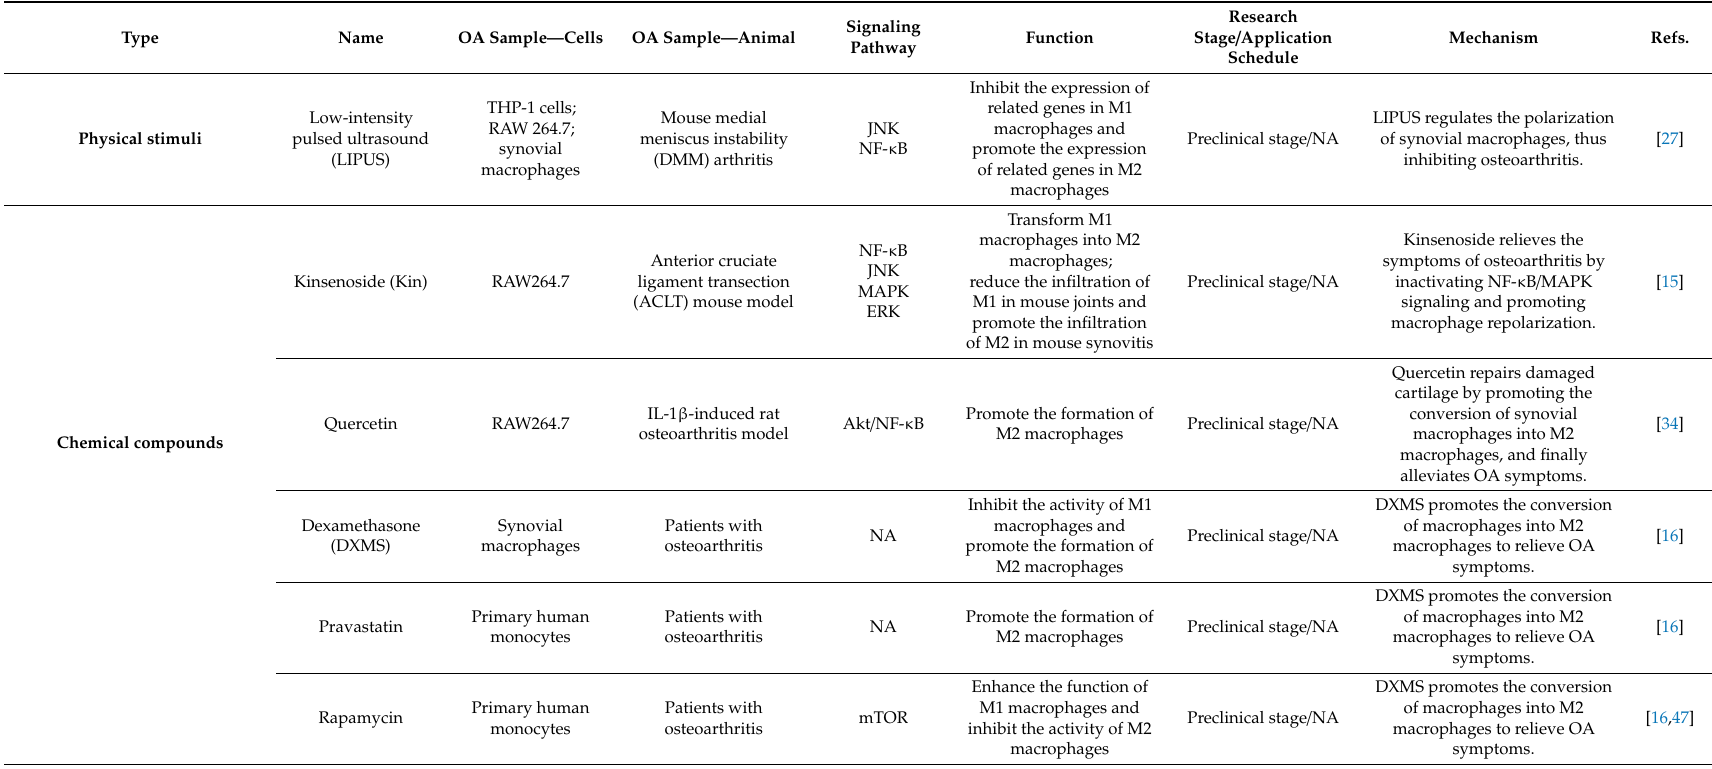
Table A1. Macrophage-based therapeutic strategies for